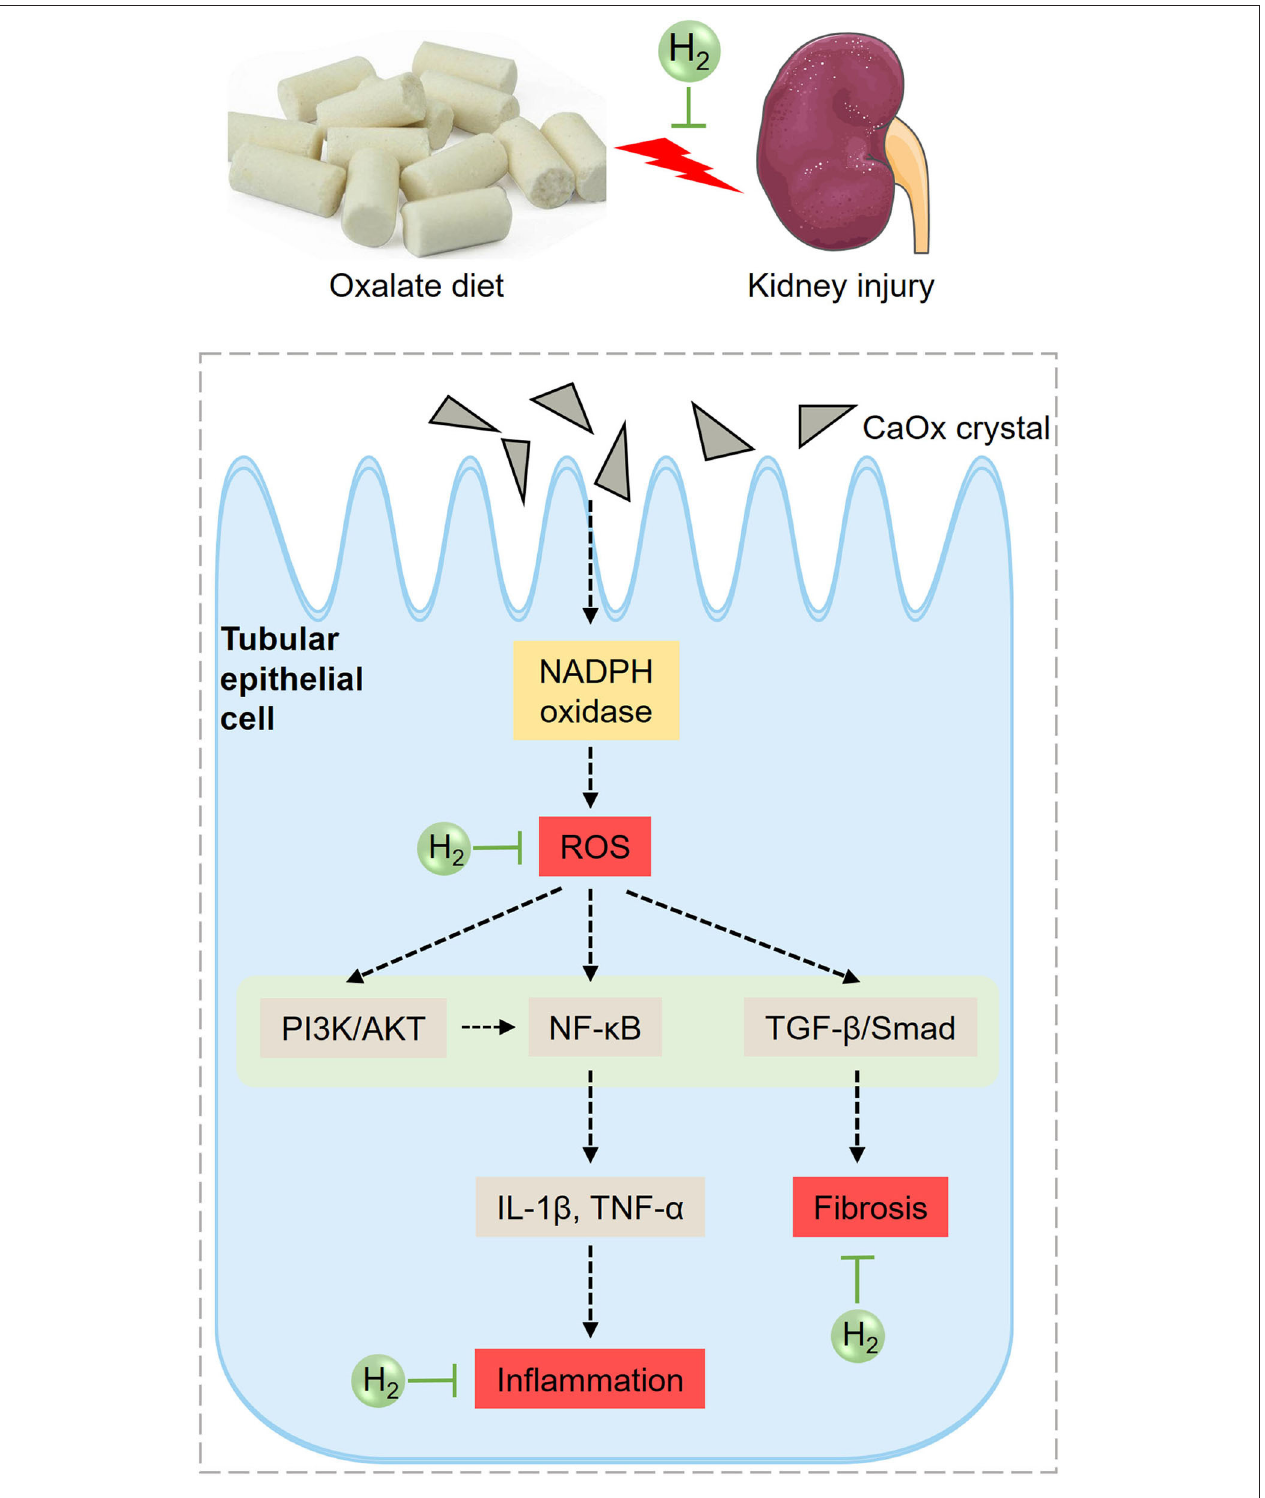
FIGURE 8 | Diagram of the effects of HRW on oxalate-induced kidney injury. The increased CaOx crystals induced by high oxalate diet activate NADPH oxidase and enhance renal ROS production. ROS can further activate PI3K/AKT, NF- κ B, and TGF- β pathways, increasing the production of inflammatory factors and collagen deposition, promoting inflammation and fibrosis. HRW may alleviate oxalate-induced kidney injury through improving oxidative stress, inflammation and fibrosis via suppressing PI3K/AKT, NF- κ B, and TGF- β signaling pathways.